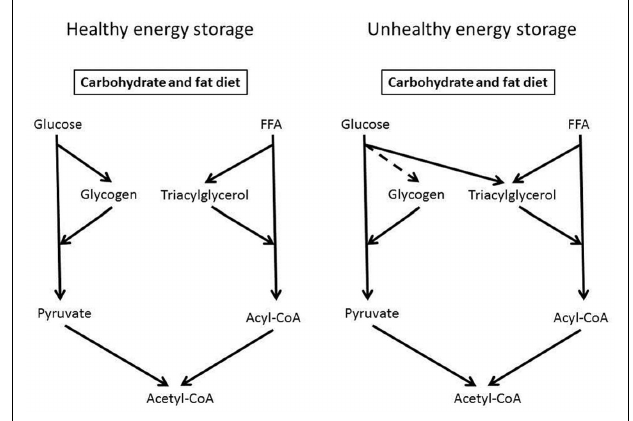
FIGURE 2 | Excess energy intake is stored after meals as glycogen and triacylglycerols. Carbohydrate can be stored as glycogen mainly in skeletal muscles or the liver; fat is manly stores as triacylglycerol in adipose tissue. With filled glycogen stores, glucose can be the substrate for de novo lipid synthesis and stored in adipocytes, muscles, or the liver and cause insulin resistance. Glycogen and fat are important energy substrates during